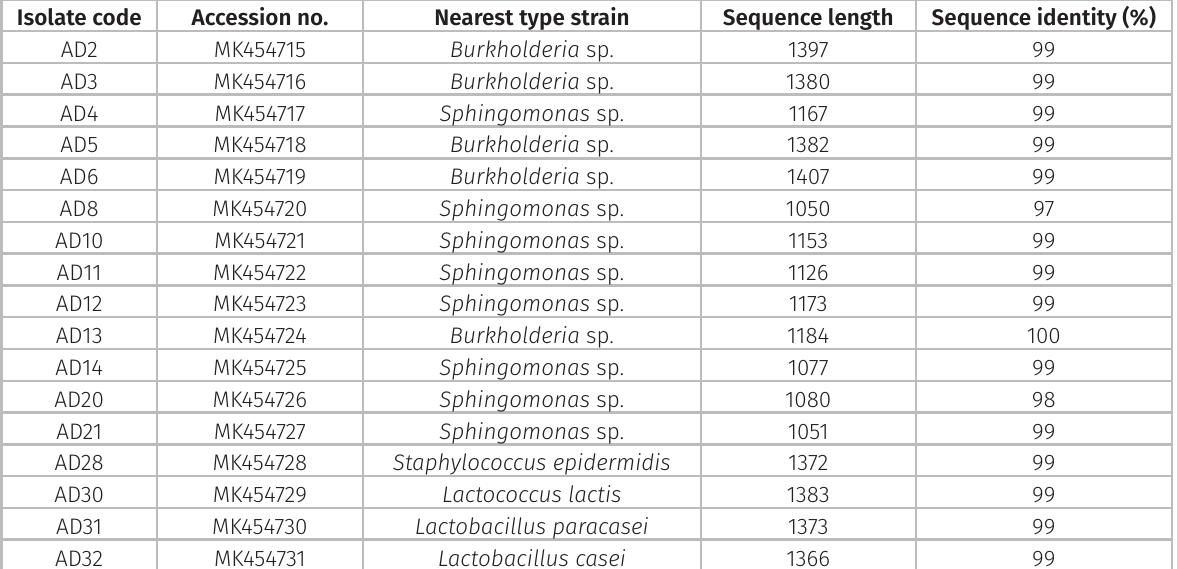
Table IV. Identification of the isolates. Isolate code Accession no. Nearest type strain Sequence